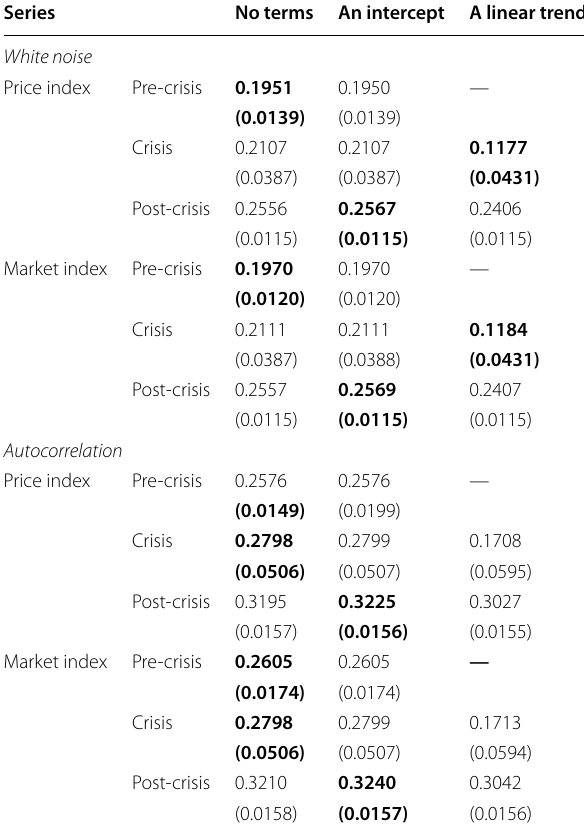
Table 8 Estimates of d for the pre- and post-crisis periods (volatility series)